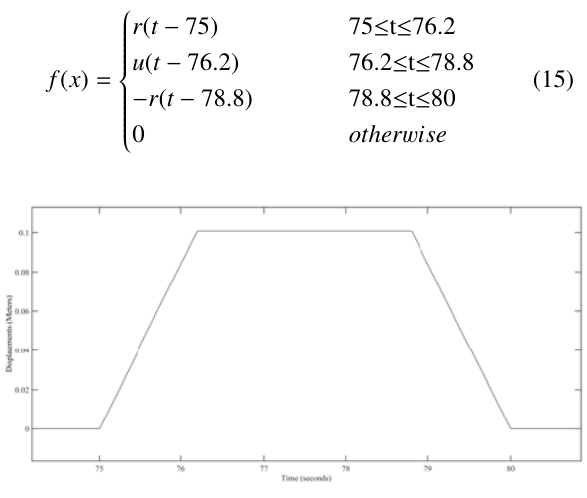
Figure 17. Road profile 3 Where, (p = 0.1m (road bump height), q = 5m(width))